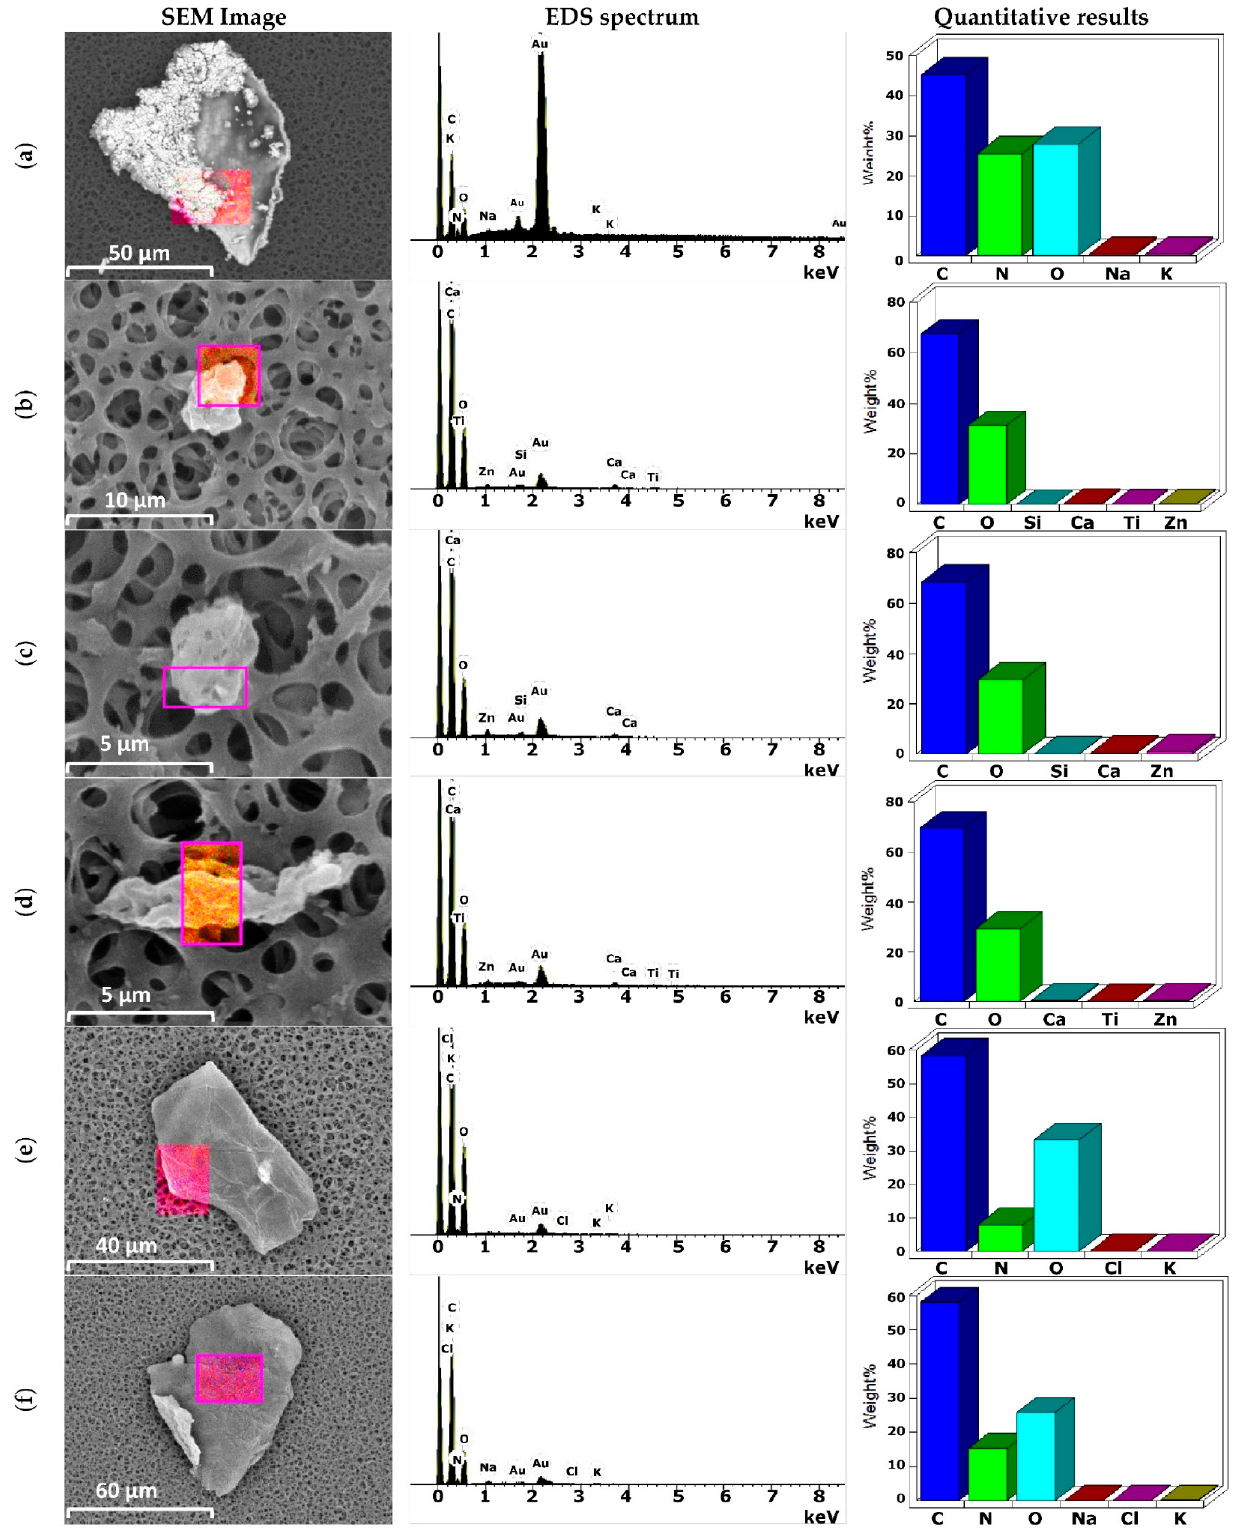
Figure 5. SEM images, EDS spectra and quantitative results of elemental analysis on the surfaces of possible MP particles ( a – f ) from grey water samples. A gold layer with a thickness of 15 nm was sputtered on the MPs’ surfaces to provide higher surface conductivity for better-quality SEM images. Please see the colour version of the image to observe all marked areas in the SEM images.